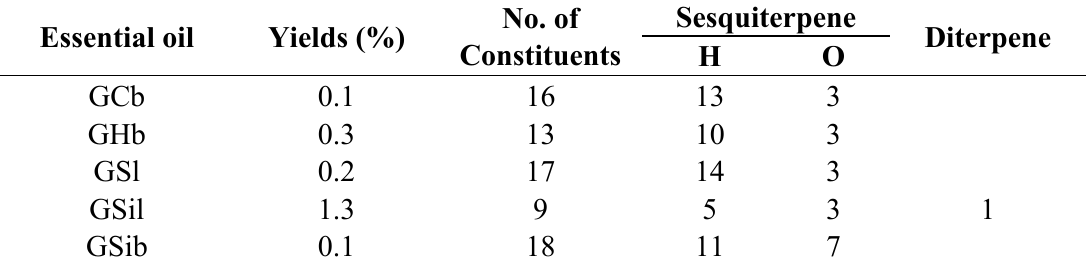
Table 1. Yields of essential oils and types of terpenoids identified.